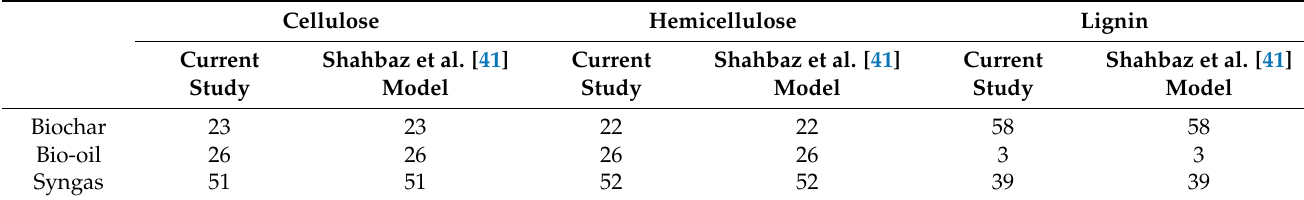
Table 4. Comparison of product yields (wt%) for cellulose, hemicellulose and